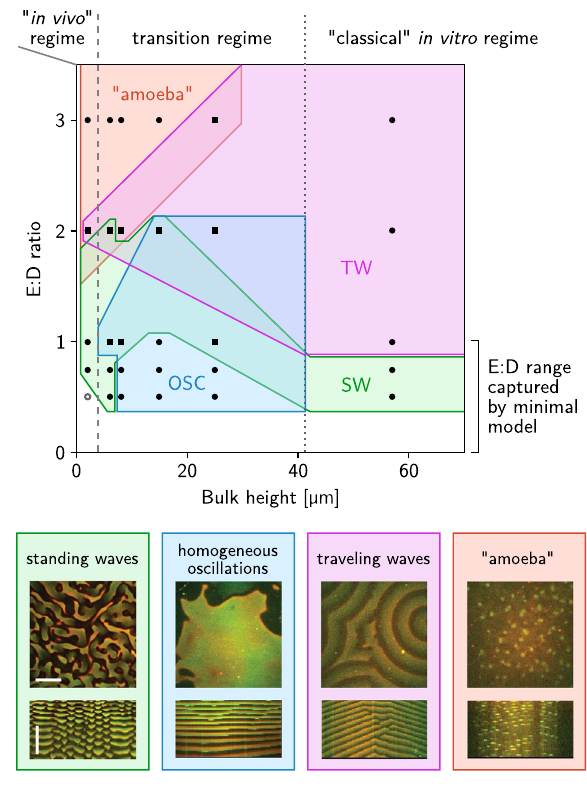
Fig. 3 Experimental phase diagram showing multistability. Black symbols mark parameter combinations where experiments were performed. To vary the E:D ratio, the concentration of MinE was varied from 0.5 to 3 μ M at a constant MinD concentration of 1 μ M. Circles (squares) mark monostable (multisatble) regions, where one (multiple) pattern types were found in repeated experiments. The observed pattern types are indicated by the colored regions; the legend shows representative snapshots and kymographs (see Supplementary Fig. 9 for representative snapshots for each parameter combination and pattern type separately). Note that the topology of the phase diagram agrees with the prediction from linear stability analysis (Fig. 2a) within the regime captured by the minimal model ( E : D < 1). (Scale bars: 50 μ m and 30